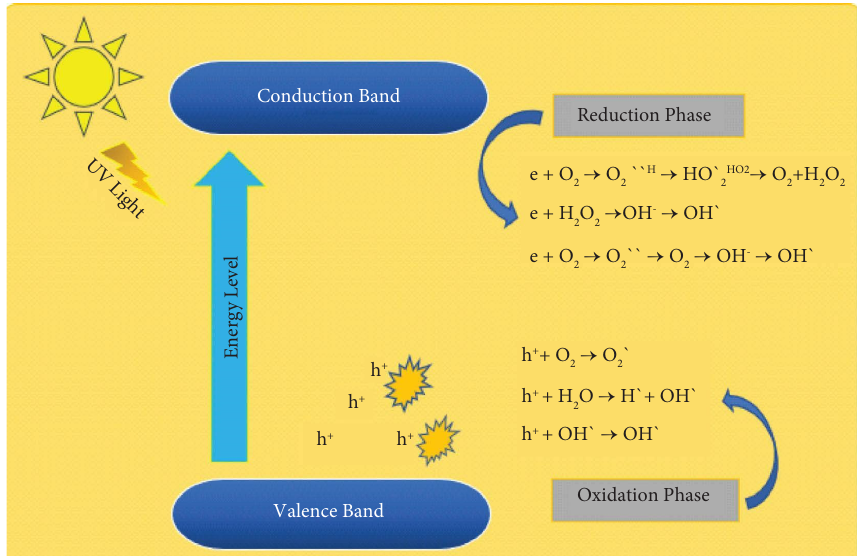
Figure 5: Basic mechanism of photocatalysis